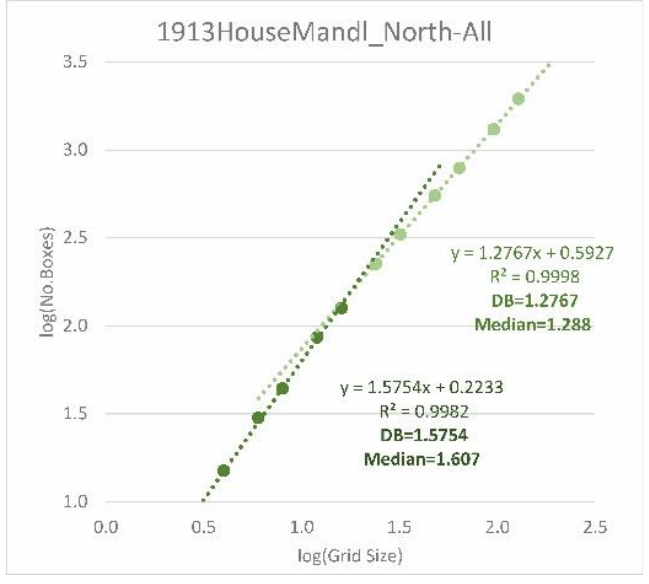
Figure 17. Comparison 𝐷 𝐵 of smallest number of covered boxes and the median. The measurement with the differential box-counting method (the measurement of color images with FRACAM) leads to fractal dimensions approximating the value